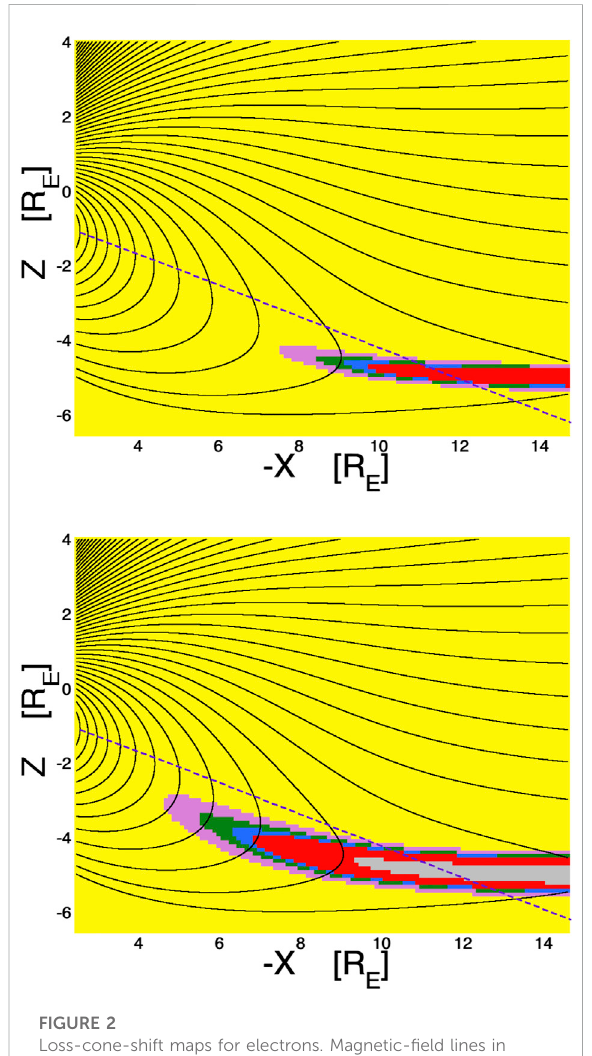
FIGURE 2 Loss-cone-shift maps for electrons. Magnetic- fi eld lines in the nightside magnetosphere in the noon-midnight meridian are drawn as the black curves using the T96 magnetic- fi eld model. The colored shading is the calculated eastward shift of the local atmospheric loss cone for 50-keV electrons (top panel) and for 1-MeV electrons (bottom panels) based on the T96 magnetic- fi eld model. The color scheme is yellow (shift < 0.5 ° ), pink (shift